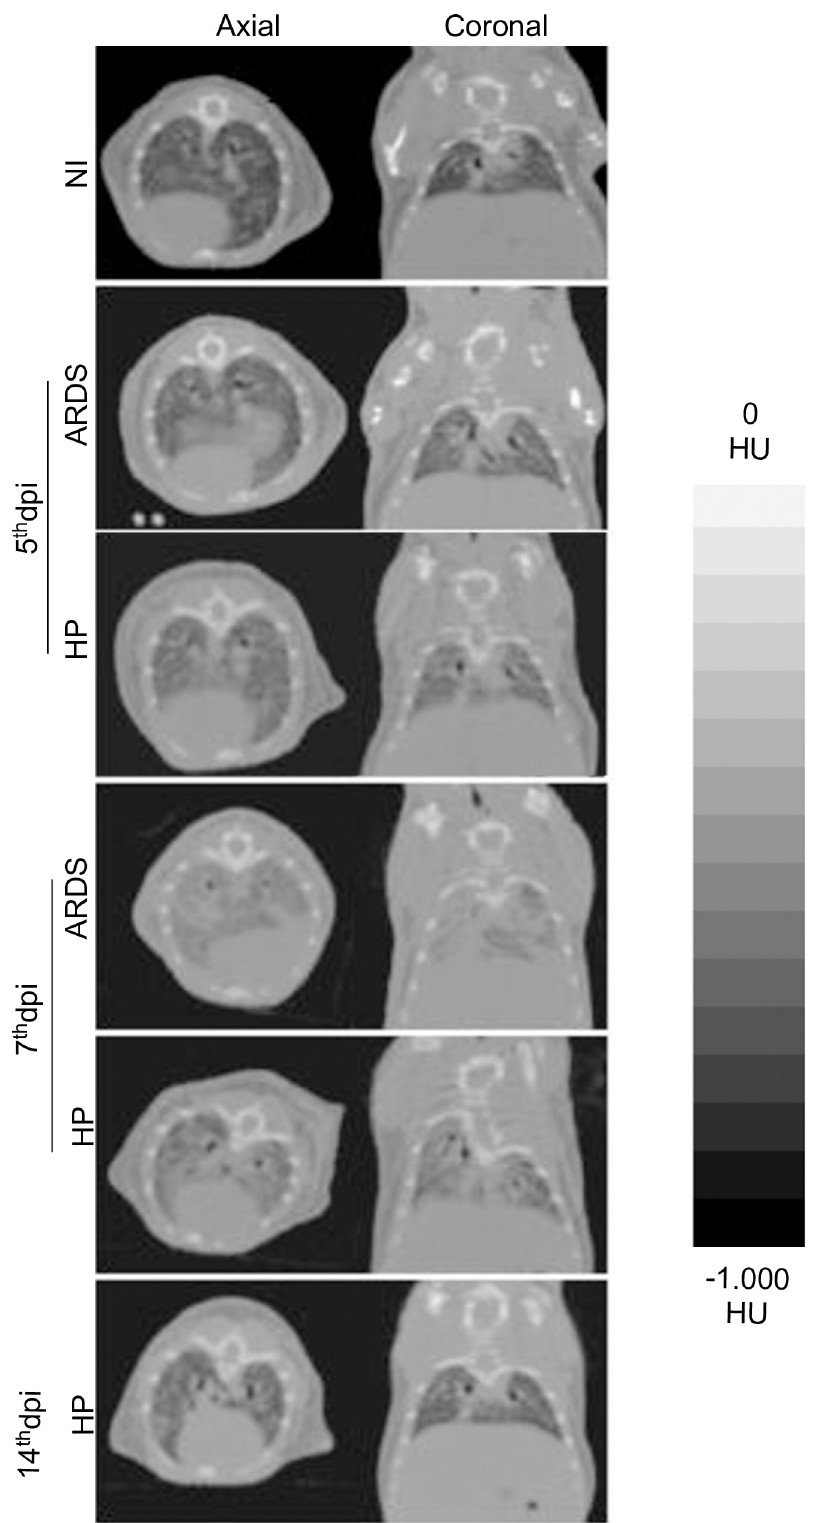
Fig 2. Morphological evaluation during the development malaria-associated ARDS by computed tomography. Representative topographic images of P . berghei ANKA-infected DBA/2 mice. The scale by Hounsfield Units 0